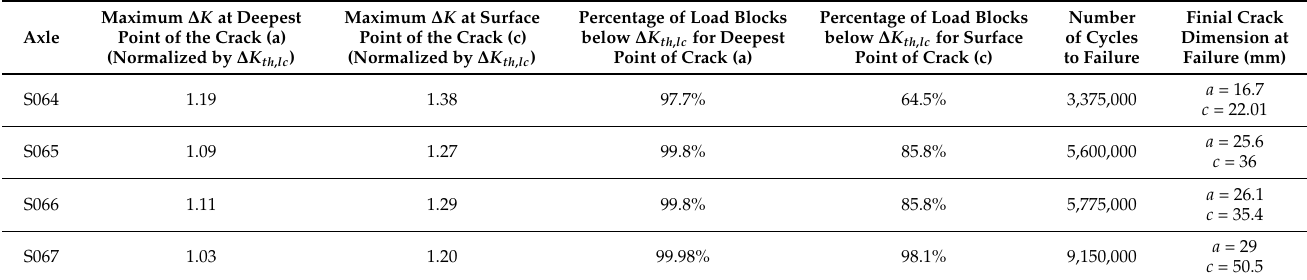
Table 3. Summary of full-scale axle test